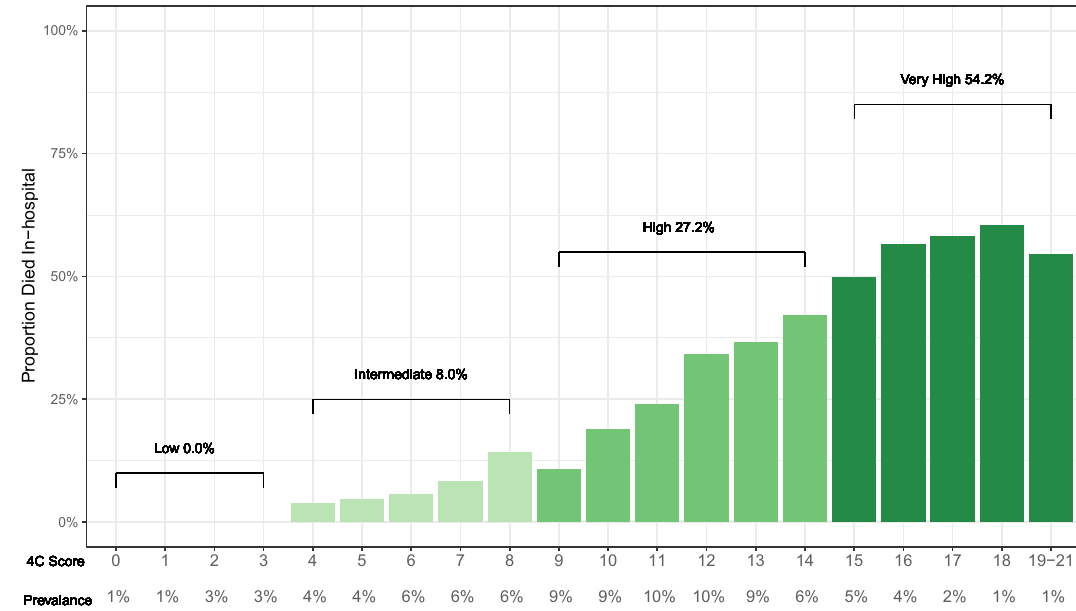
Figure 1. Proportion of COVID-19 inpatients who died by 4C mortality score and risk group.